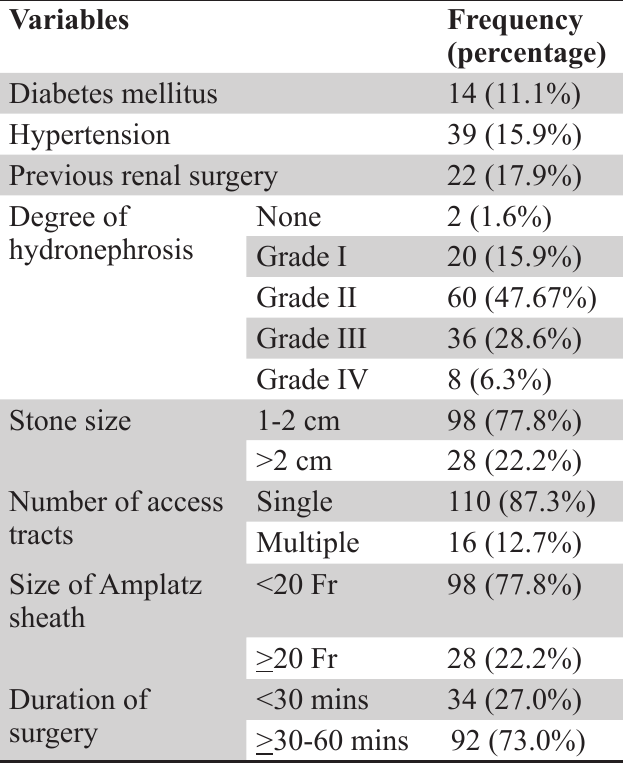
Table 1. Pre- and peri-operative findings in the study population